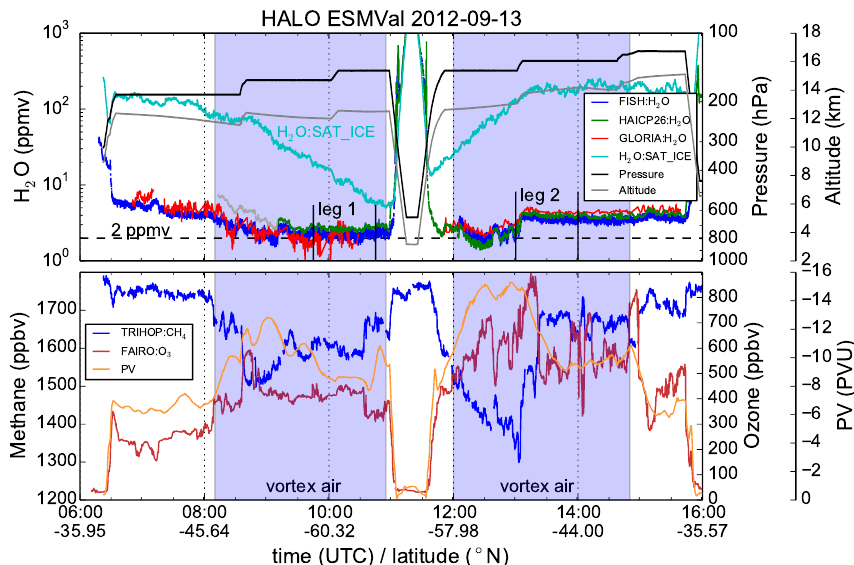
Figure 3. Time series of ESMVal Antarctica flight on 13 September 2012: the upper panel shows FISH (blue), HAI (green) and GLORIA (red) water vapor measurements, water vapor saturation mixing ratio with respect to ice (cyan, derived from HALO temperature), pressure (black), and altitude (gray) at flight level. The lower panel shows the tracer observation ozone (red), methane (blue) and interpolated ECMWF PV values (orange). Time ranges within the vortex are marked with light-blue shadows according to the tracer measurements. Time ranges leg one and leg two are marked for hygrometer intercomparison of FISH and HAI (see